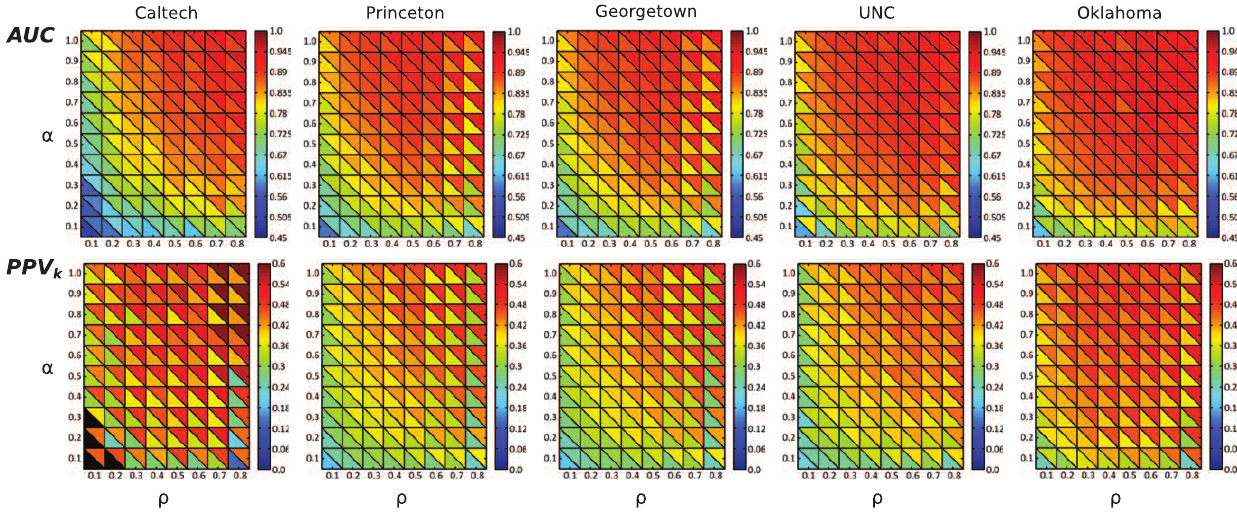
Figure 6. 4 R 1 cross-prediction accuracy. Minimal (lower triangle) and maximal (upper triangle) prediction accuracy for all five member recruitment models are shown as a function of platform penetration r and the disclosure parameter a . Upper row: AUC ; lower row: PPV k ; black triangles denote data points where PPV k was smaller than the according fraction of positive samples among all samples.